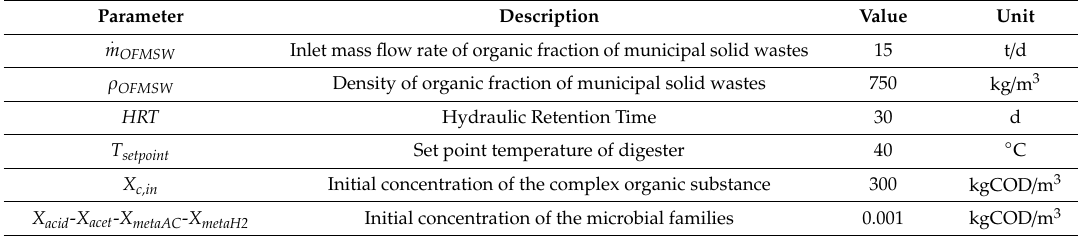
Table 7. Inlet parameters of the developed